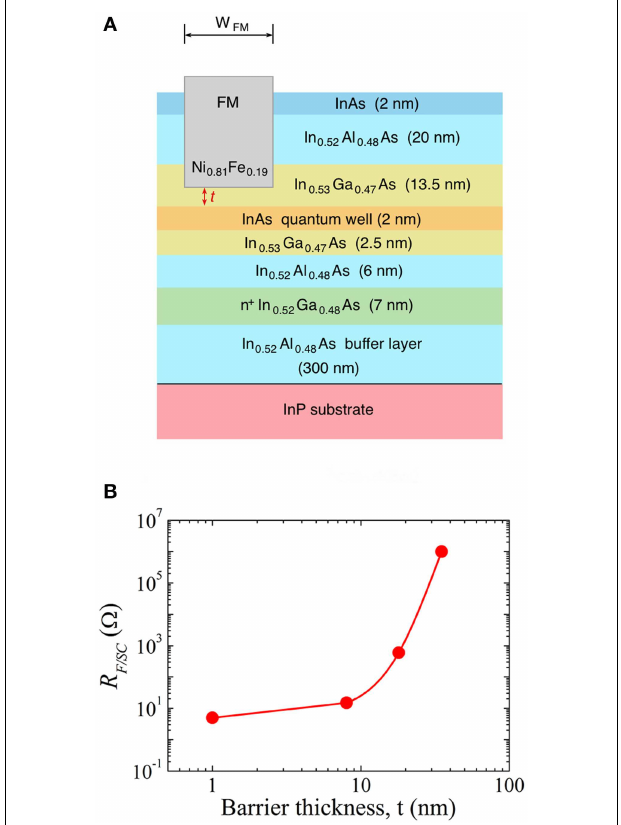
FIGURE 6 | (A) Cross-section of InAs SQW heterostructure and FM electrode. During fabrication of the FM electrode, a trench is made by an ion mill etch, leaving a distance t to the top of the QW. Permalloy is deposited in the trench. (B) Interface resistance, R F / 2 DEG , as a function of thickness t . The interface area is about 15 square microns. Reproduced from Chang et al.